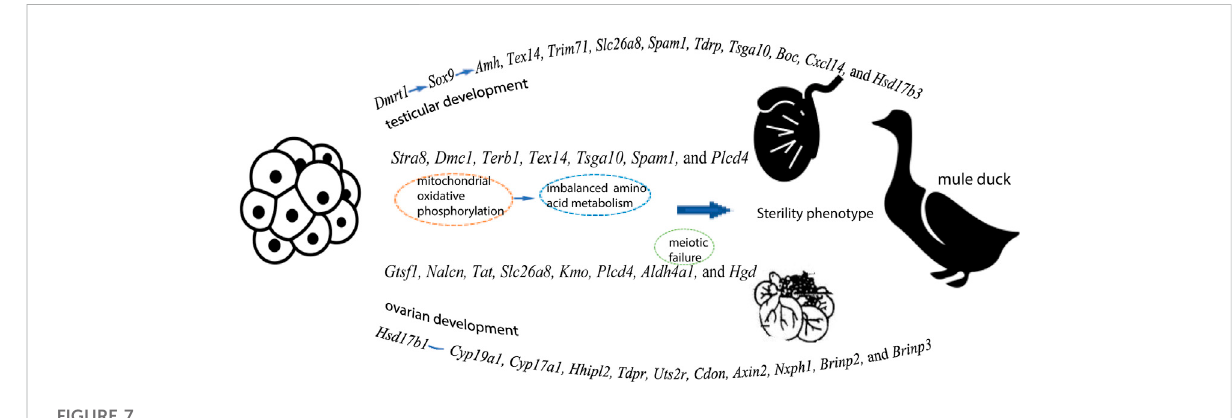
FIGURE 7 A speculation explaining the gene expression pattern in testes and ovaries, as well as the sterility in Mule